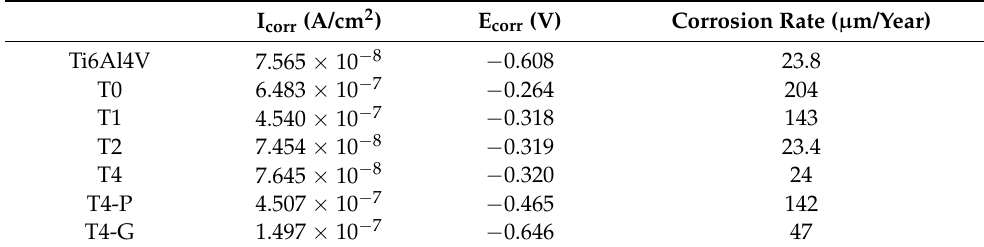
Table 3. The I corr , E corr, and corrosion rate of different